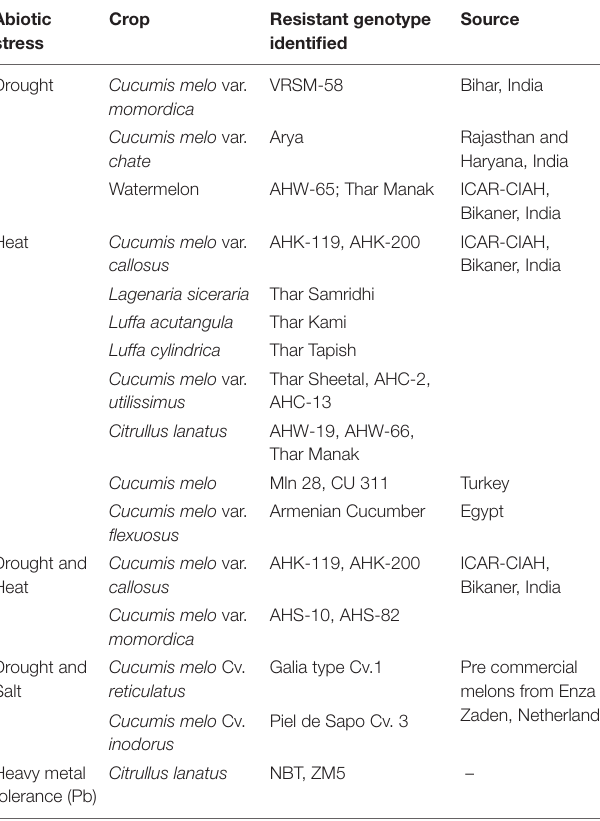
TABLE 10 | Abiotic stress tolerant genotypes/species of cucurbits. Abiotic